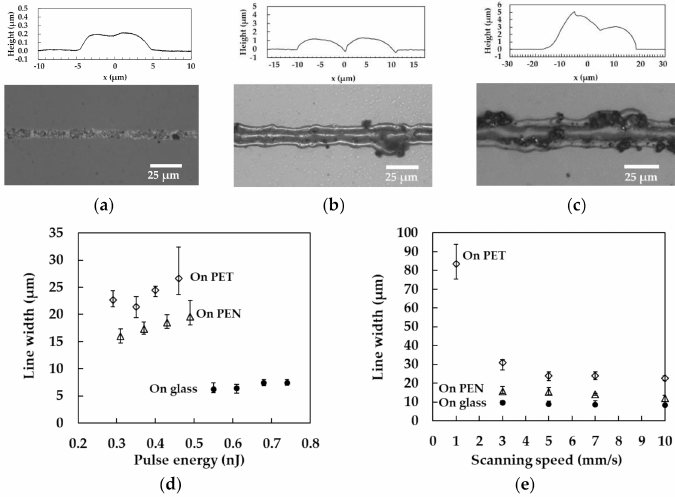
Figure 3. ( a – c ) Optical microscope images and cross-sectional profiles of the minimum line patterns fabricated on glass, PEN, and PET substrates, respectively. Dependences of the line width of the patterns on ( d ) the pulse energy at a scanning speed of 5 mm/s and ( e ) the scanning speed. The data points shown correspond to energies of 0.29, 0.31, and 0.68 nJ on PET, PEN, and glass substrates,